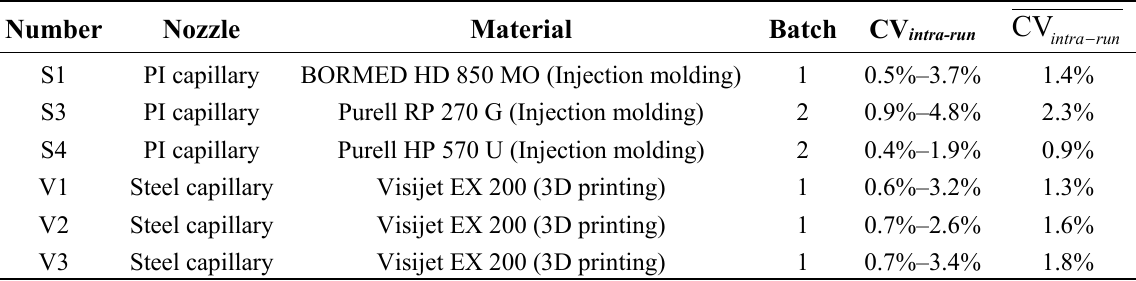
Table 2. Precision data of three injection-molded and three 3D printed valves out of different fabrication batches having different nozzles (as shown in Figure 9). The was calculated as average over different volumes as displayed in Figure CV intra run −